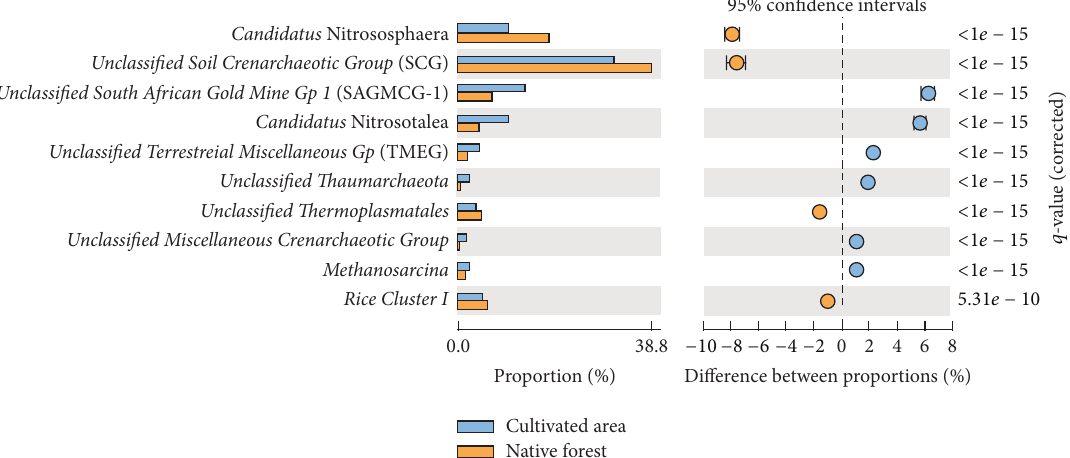
Figure 7: Archaeal genera that differ significantly ( 𝑞 < 0.05 ) in relative abundance between native forest soil (orange) and soil under oil palm cultivation (blue). For the purpose of statistical analysis performed using STAMP software, the sum of the percentages of archaea classified at the genus level in both soils is 100%. Differences between proportions of each genus are shown with 95% confidence intervals. Unclassified sequences were used to calculate frequency profiles but are not